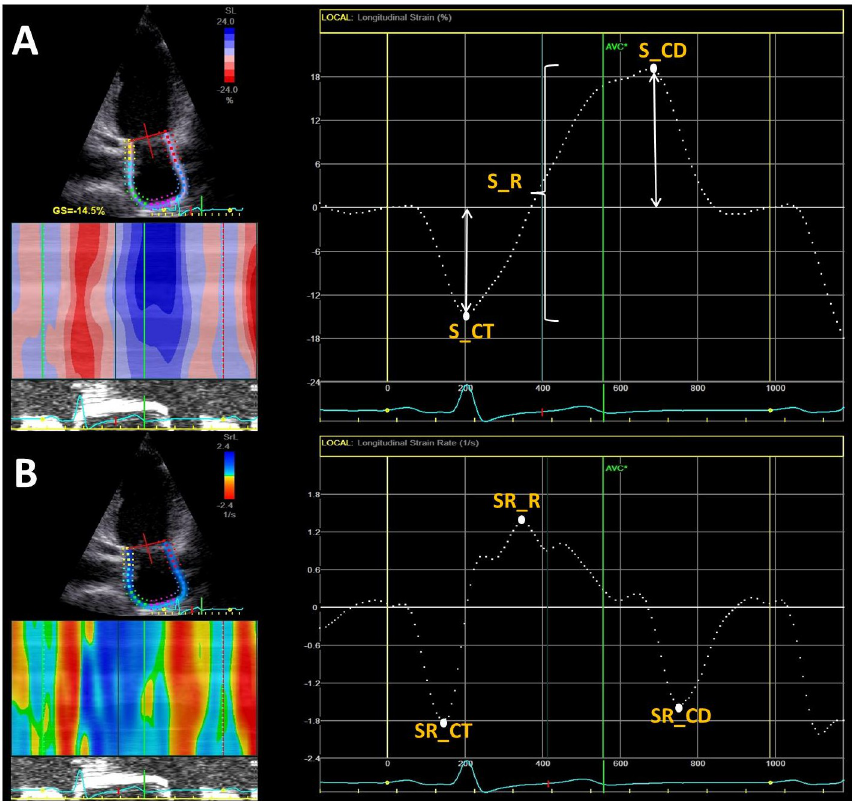
Fig 1. LA strain by speckle tracking echocardiography. Example of left atrial strain (panel A) and strain rate (panel B) from four-chamber apical view, using speckle tracking echocardiography, illustrating reservoir, conduit and pump deformation in a diastolic dysfunction patient. S_R, reservoir strain; SR_R, reservoir strain rate; S_CD, conduit strain; SR_CD, conduit strain rate; S_CT, contractile strain, SR_CT, contractile strain rate.